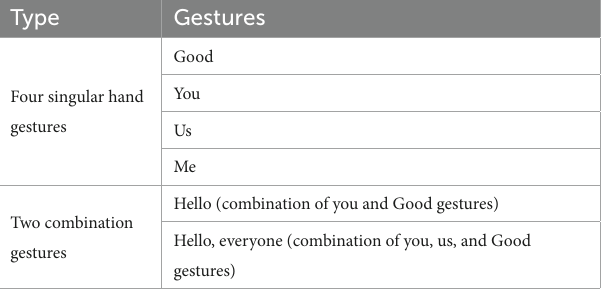
TABLE 3 All testing gestures in the second